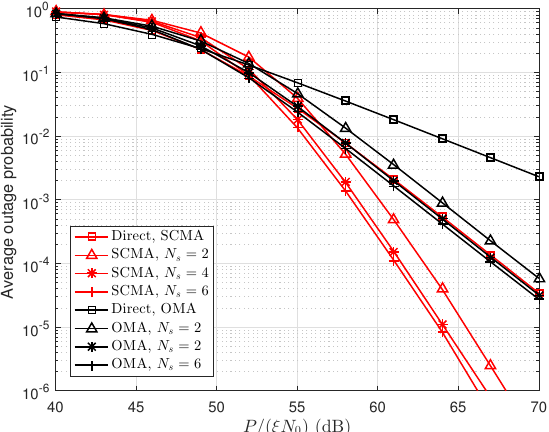
Figure 3. The average outage probability versus P / ( ξ N 0 ) .